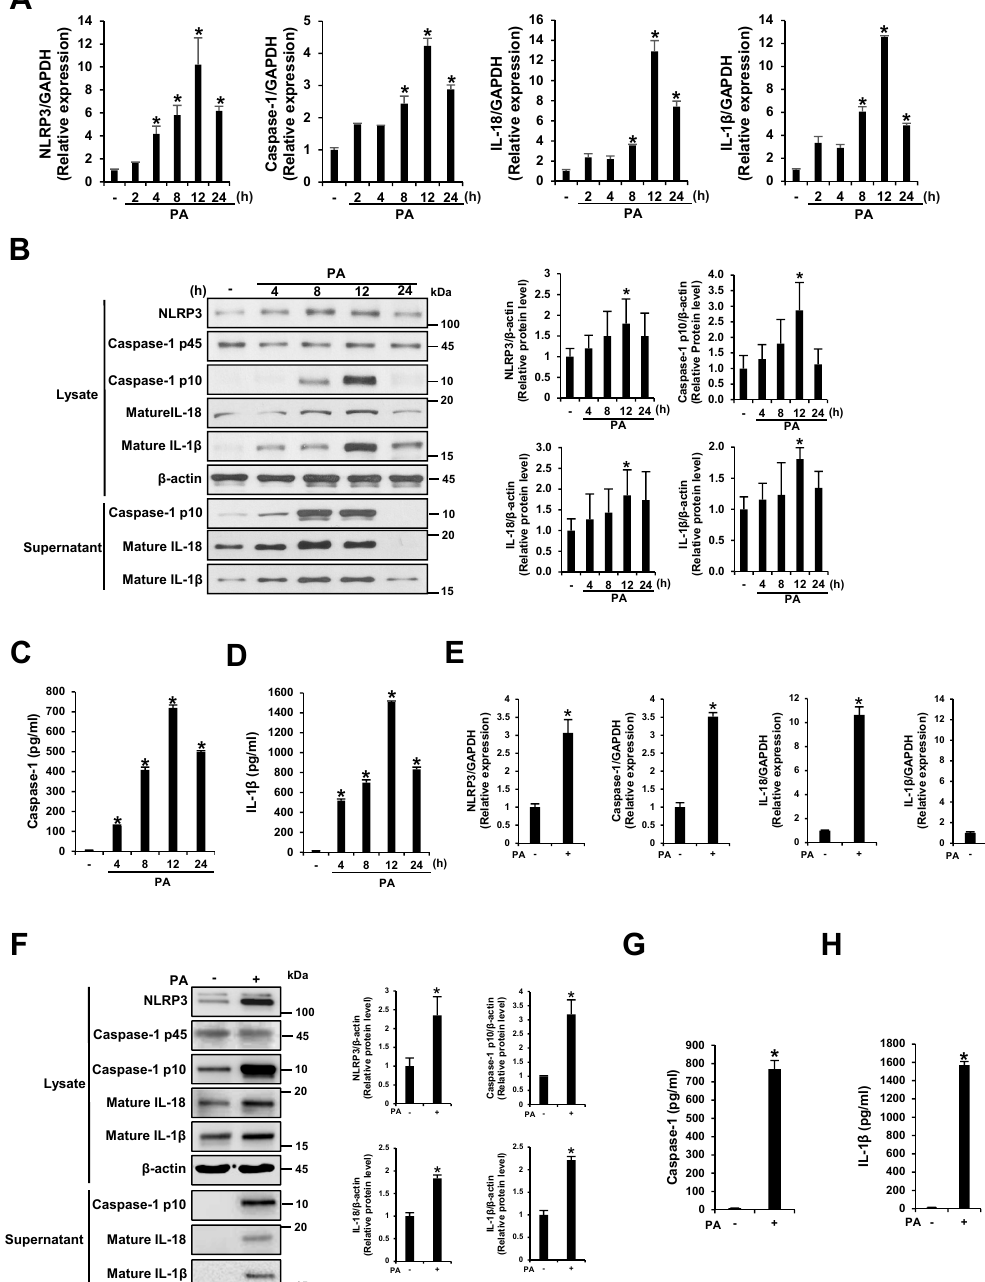
Figure 1. Palmitate (PA) induces NLRP3 inflammasome activation. ( A ) THP-1 cells were treated with 200 µ M PA for 2, 4, 8, 12, and 24 h. The mRNA levels of NLRP3, caspase-1, interleukin (IL)-18, and IL-1 β were examined by quantitative RT-PCR; ( B ) THP-1 cells were treated with 200 µ M PA for 4, 8, 12, and 24 h. Cell lysates and supernatants were subjected to immunoblotting using antibodies specific for NLRP3, caspase-1, IL-18, IL-1 β , and β -actin. Relative protein levels were analyzed with ImageJ; ( C , D ) The levels of caspase-1 and IL-1 β in the culture supernatants were determined by ELISA; ( E – H ) Primary murine macrophages were treated with 200 µ M PA for 12 h; ( E ) The mRNA levels of NLRP3, caspase-1, IL-18, and IL-1 β were measured by quantitative RT-PCR; ( F ) Cell lysates and supernatants were subjected to immunoblotting using antibodies specific for NLRP3, caspase-1, IL-18, IL-1 β , and β -actin. Relative protein levels were analyzed with ImageJ; ( G , H ) The levels of caspase-1 and IL-1 β in the culture supernatants were determined by ELISA. * p < 0.05 compared with PA-untreated